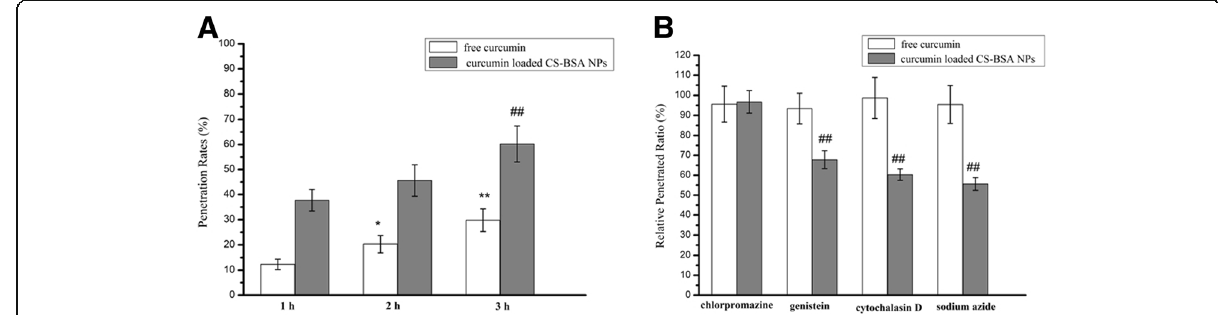
Fig. 2 Analysis of the penetration mechanism of free curcumin and curcumin-loaded CS-BSA NPs through hCMEC/D3 cells. a Fluorescence spectrum analysis of the penetration rates of free curcumin and curcumin-loaded CS-BSA NPs. Results are expressed as means ±standard deviation ( n =3). * P <0.05, ** P <0.01 vs the penetration rates of free curcumin at 1 h. ## P <0.01 vs the penetration rates of curcumin loaded CS-BSA NPs at 1 h. b Effects of endocytic inhibitors on the penetrated ability of free curcumin and curcumin-loaded CS-BSA NPs. Results are expressed as means± standard deviation ( n =3). ## P <0.01 vs relative penetrated ratio of curcumin loaded CS-BSA NPs treated with